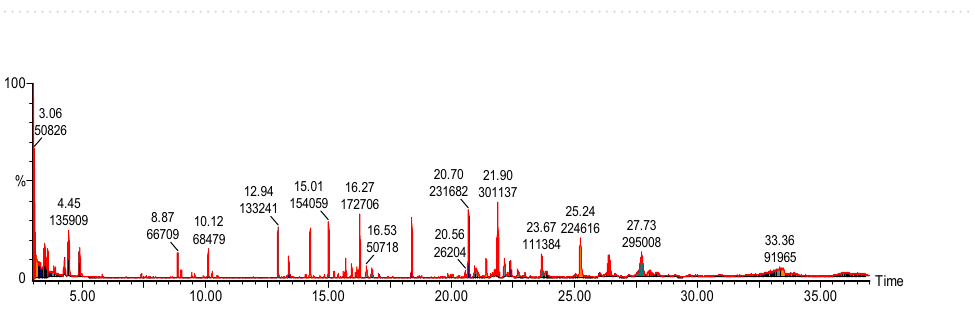
Figure 6. GC–MS Chromatogram of ethyl acetate extracts of callus grown on simple callus promoting media (CPM) supplemented with Kinetin (0.5 mgL -1 ) and 2.4-D (1.0 mgL -1 ).